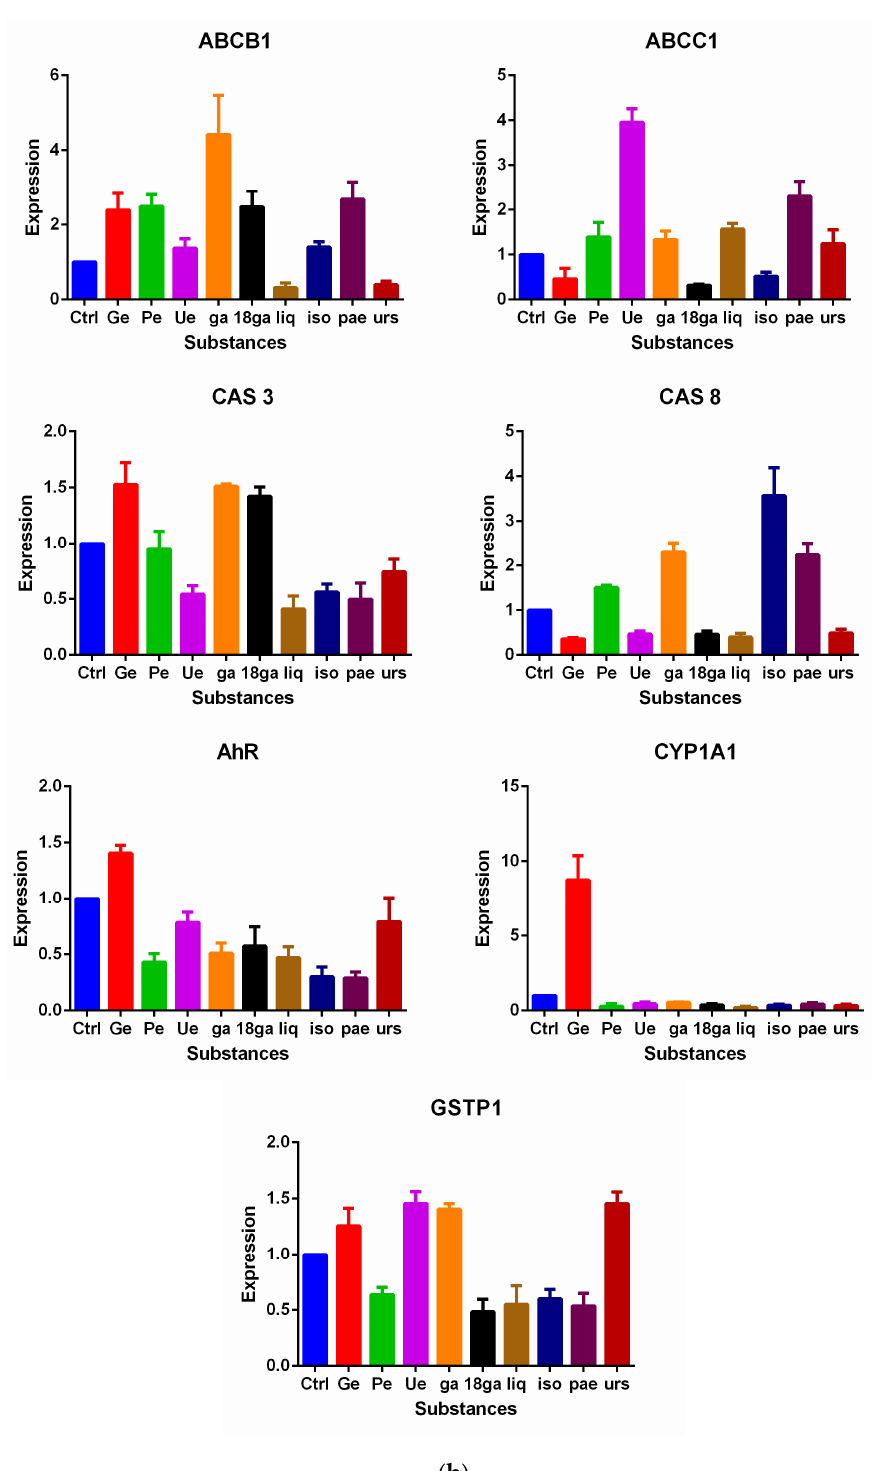
Figure 5. Effects of non-toxic doses of plant secondary metabolite (PSM) on the expression of various genes after 48 h treatment compared to the control (no treatment) in CEM/ADR 5000 cells ( a ) and Caco-2 cells ( b ). Concentrations were the same as used in Table 2 (CEM/ADR 5000 cells) and Table 3 (Caco-2 cells). The results are expressed as the mean ± SD represented at least three independent experiments. The non-treated control group was defined as 1.00.